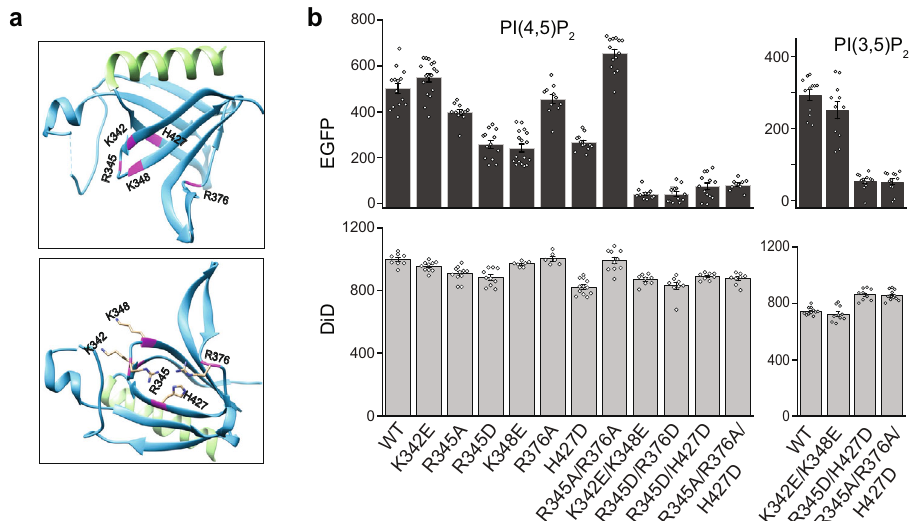
Fig. 4 Mutations in the PH domain differentially abolish ARHGEF3 binding of PI(4,5)P 2 and PI(3,5)P 2 . a Ribbon representation of the structure of ARHGEF3 PH domain (PDB ID: 2Z0Q; 22 image created with Pymol v2.5), with residues predicted to interact with PIP highlighted in magenta and the sidechains of those residues shown in the lower panel. b HEK293 cells were transiently transfected with EGFP-ARHGEF3 containing various mutations at the residues highlighted in ( a ), and the lysates were subjected to SiMPull assays against vesicles containing PI(4,5)P 2 or PI(3,5)P 2 . Numbers of fl uorescent molecules per image area are shown in the graphs. Data are presented as mean ± SEM. N ≥ 10 images for EGFP; N ≥ 6 images for DiD. Source data are provided as a Source Data fi le, which lists the exact N number for each data point. Each assay was performed with at least three independent transfections with similar